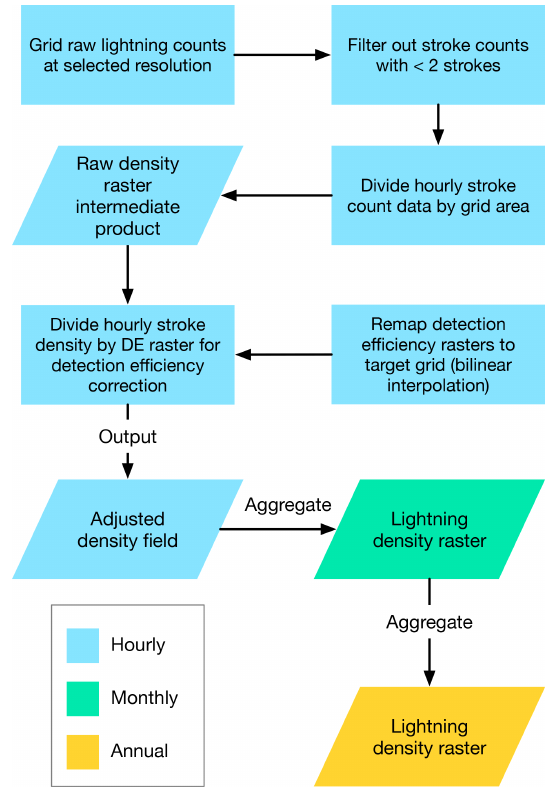
Figure 1. Flowchart of the WGLC gridding and detection efficiency adjustment